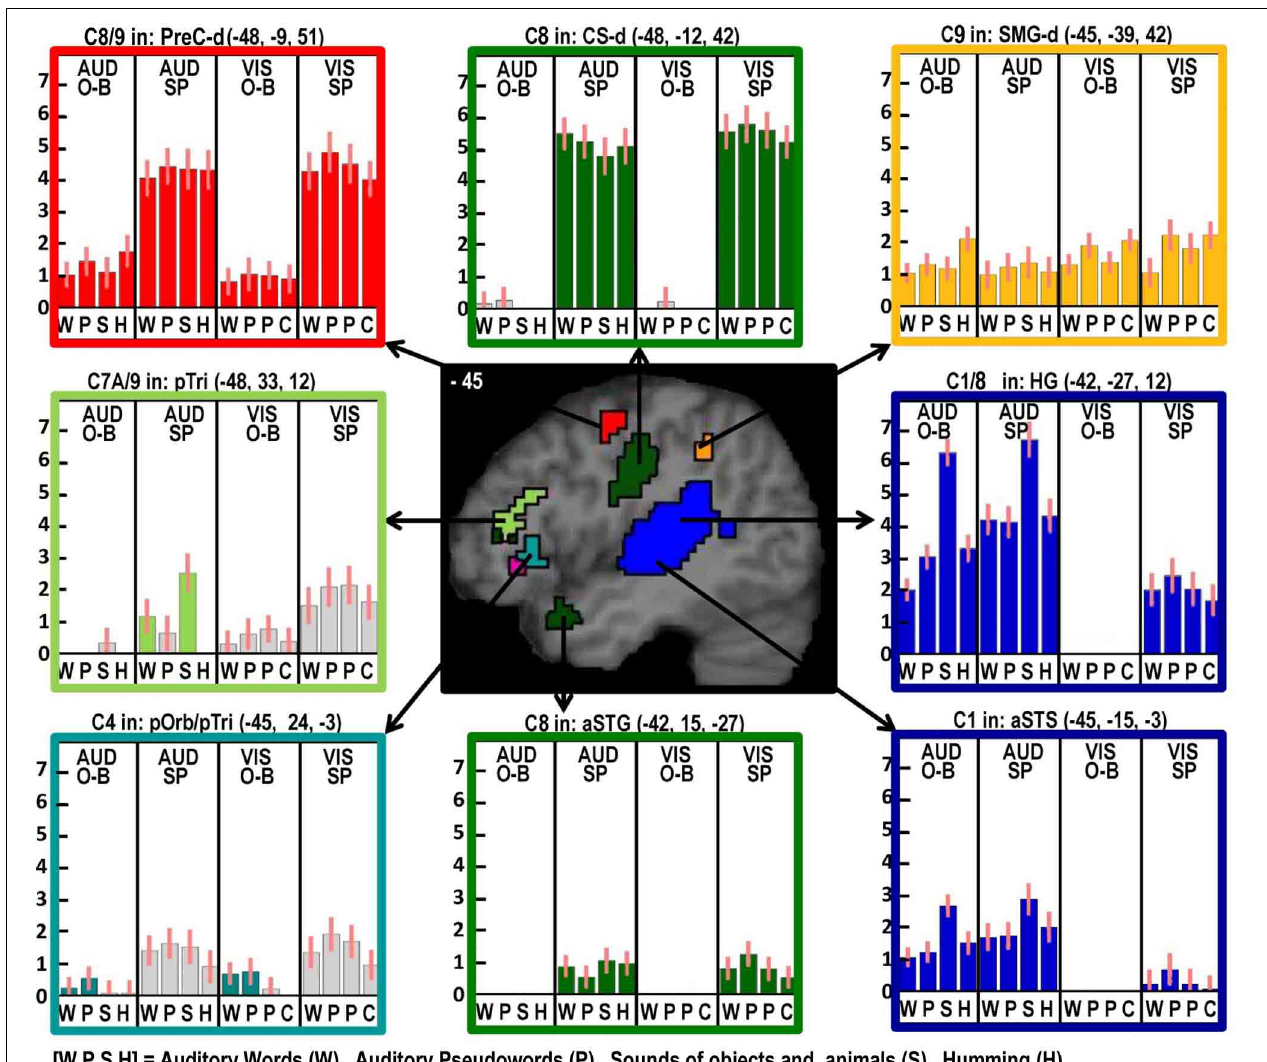
FIGURE 3 | As in Figure 2 but with effects located at x = − 45 in MNI space. Effects colored yellow/orange are those related to domain general processing. Effects in red are those that show an effect of domain general